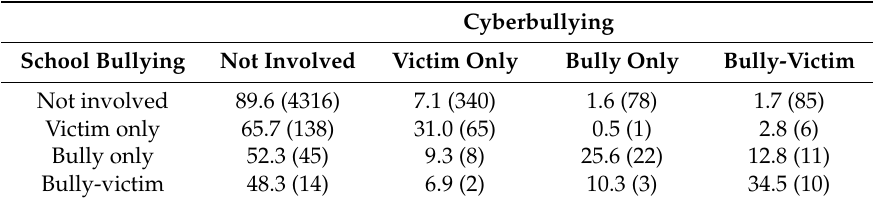
Table 2. Involvement in school bullying by involvement in cyberbullying. Row percent ( n within brackets). n =